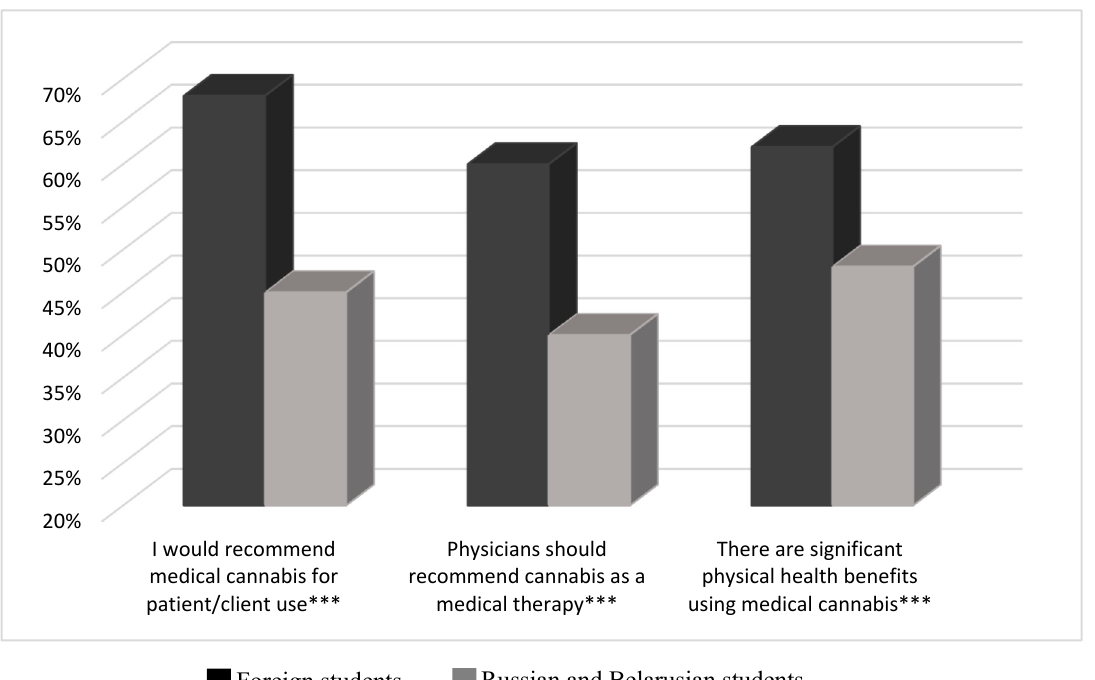
Figure 1. Medical cannabis attitudes among medical students. *** p < 0.001 (Chi-square test).